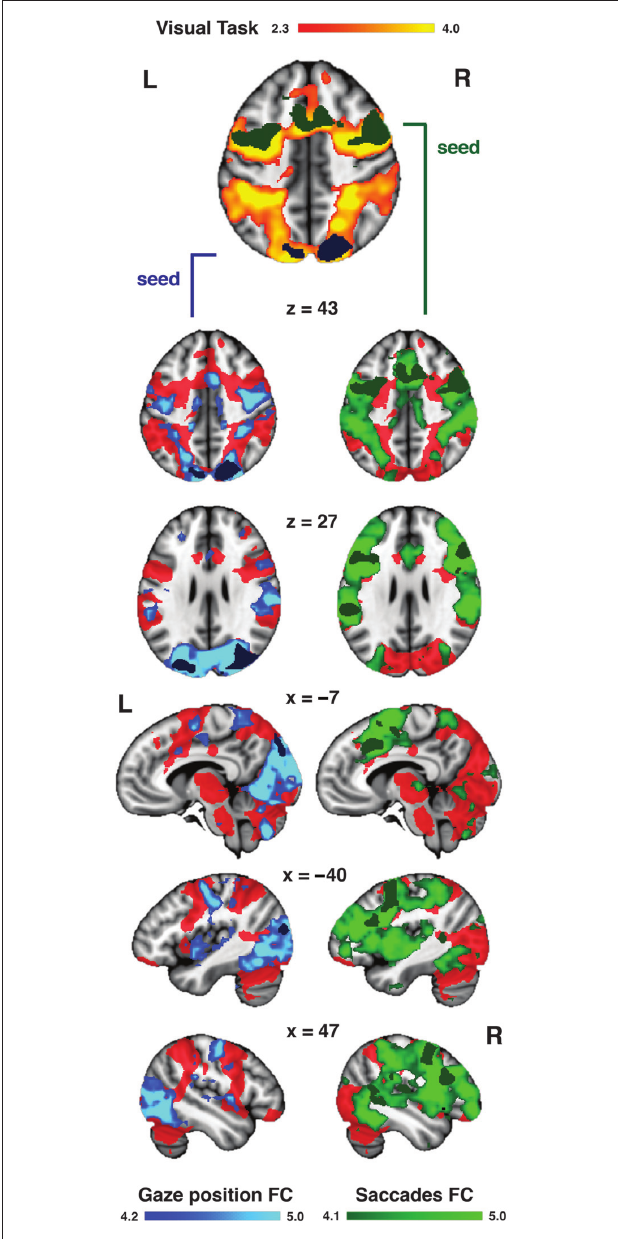
FIGURE 5 | Auditory task-evoked eye movement regions overlap with DAN. A visually cued saccade task was used to functionally define the DAN (red) in our dataset. The regions (from Figure 4 ) associated with increased gaze position bias (blue) and saccade inhibition (green) were used as seeds to assess intrinsic functional connectivity (FC) in the resting state. Both FC maps overlapped considerably with the DAN. The saccade inhibition FC map also revealed stronger connectivity with anterior prefrontal and auditory regions in the temporal lobe. The gaze position bias FC map also revealed strong connectivity with the dorsal and ventral visual